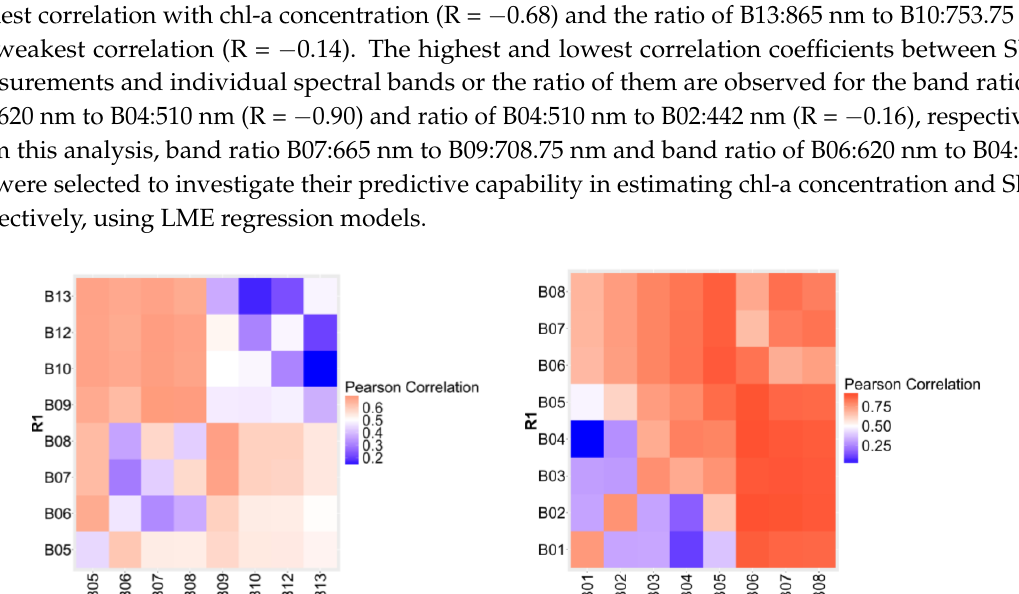
Figure 3. Probability density function of in situ chl-a ( a ) and SDD ( b ) in Lake Erie.